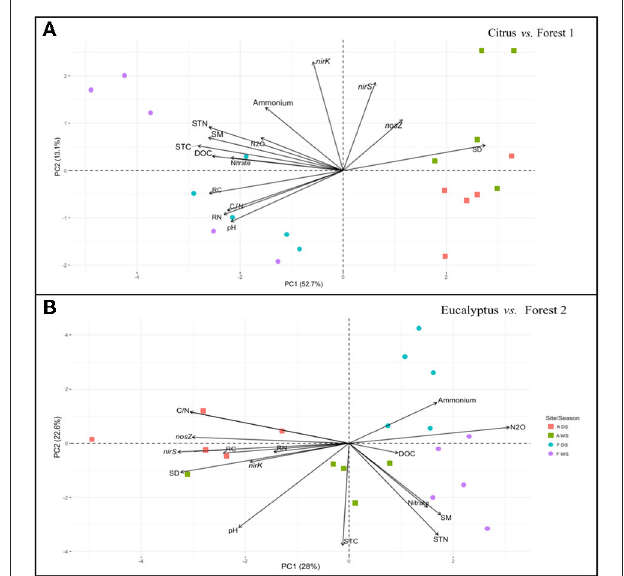
FIGURE 3 | Principal component analysis plot based on the nirK, nirS, and nosZ gene abundances, N 2 O fluxes, and soil physicochemical and plant residue chemical factors as determined in the field samples. (A) Citrus and Forest 1 sites and (B) Eucalyptus and Forest 2 sites. The symbols refer to replicates of soil from the following sampling sites and seasons: agricultural sites in the dry season (ADS), agricultural sites in the wet season (AWS), forest sites in the dry season (FDS), and forest sites in the wet season (FWS). C/N, from soil total C and N; DOC, Dissolved organic carbon; N 2 O, Nitrous oxide;